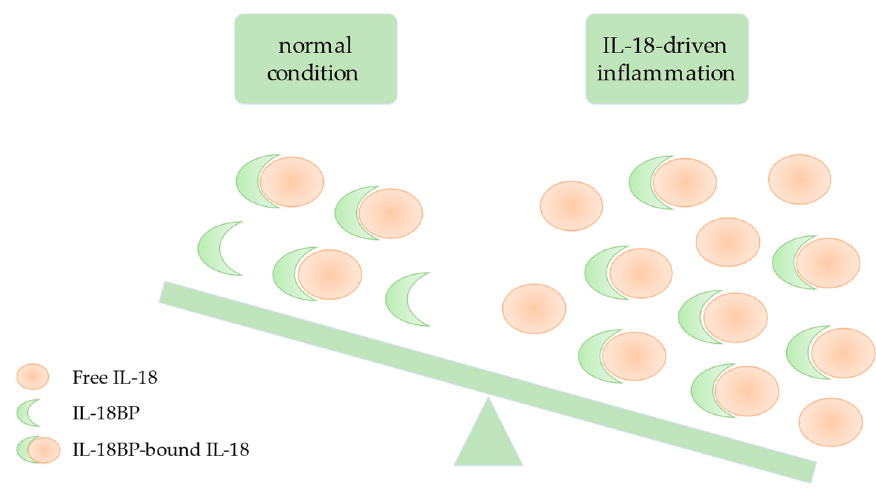
Figure 2. Schematic representation of IL-18/IL-18BP imbalance in AOSD and sJIA. In healthy individuals and most inflammatory diseases, elevated concentrations of IL-18BP and its high affinity for IL-18 causes basically all IL-18 to be buffered by IL-18BP, thus inactive (since unable to bind to IL-18 receptor) (left part of the figure). During active AOSD and sJIA, despite increased circulating levels of IL-18BP, its buffering capacities are overwhelmed by more elevated levels of IL-18 (right part of the figure). Some circulating IL-18 remains unbound to IL-18BP, meaning “free” and biologically active.